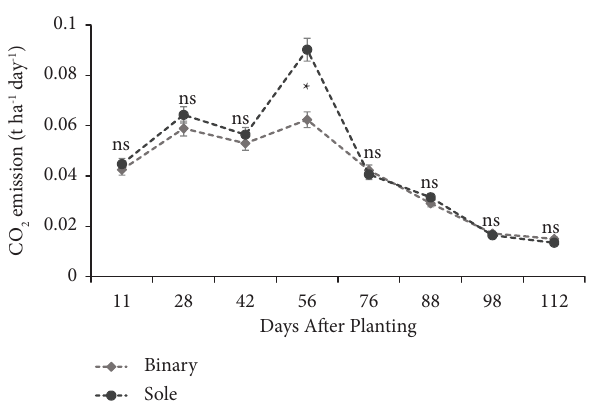
Figure 7: CO 2 emission rates in intercropping (binary) and sole cropping system during the 2020/21 cropping season at Syferkuil. ns � not signifcant; ∗ � signifcant at p ≤ sorghum sole (0.09 t · ha − 1 · day − 1 ) and the combination of sorghum and cowpea (0.07 t · ha − 1 · day − 1 ) at Ofcolaco (Fig- ure 12). However, CO emissions were similar for cowpea 2 and sorghum in sole and binary at 49 days after planting. From 63 to 101 days after planting, cowpea sole had a higher emission of CO compared to sorghum sole as well as the 2 combination of the two crops.